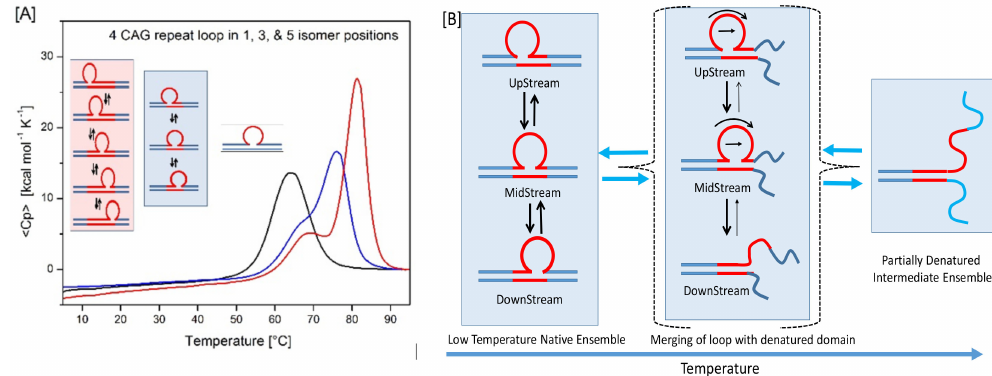
Figure 2. ( A ) Characteristic changes in the excess heat capacity profiles of a static (CAG)4 repeat bulge loop (black) compared to the same (CAG)4 bulge loops existing as three (blue) or five (red)